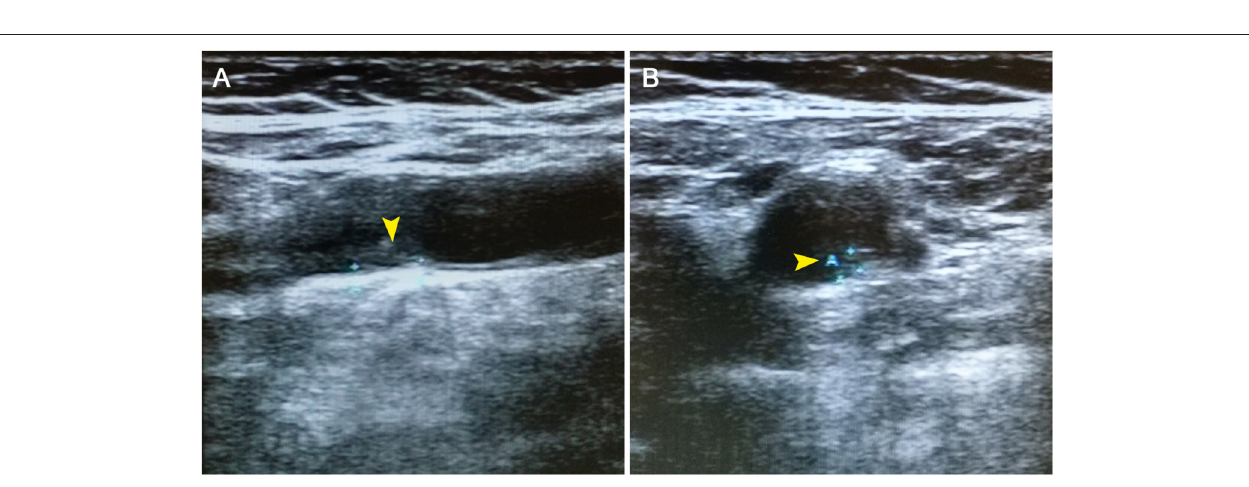
FIGURE 2 | Cervical color doppler ultrasonography revealing atherosclerotic plaques ( A , B , arrowheads) of the left internal carotid